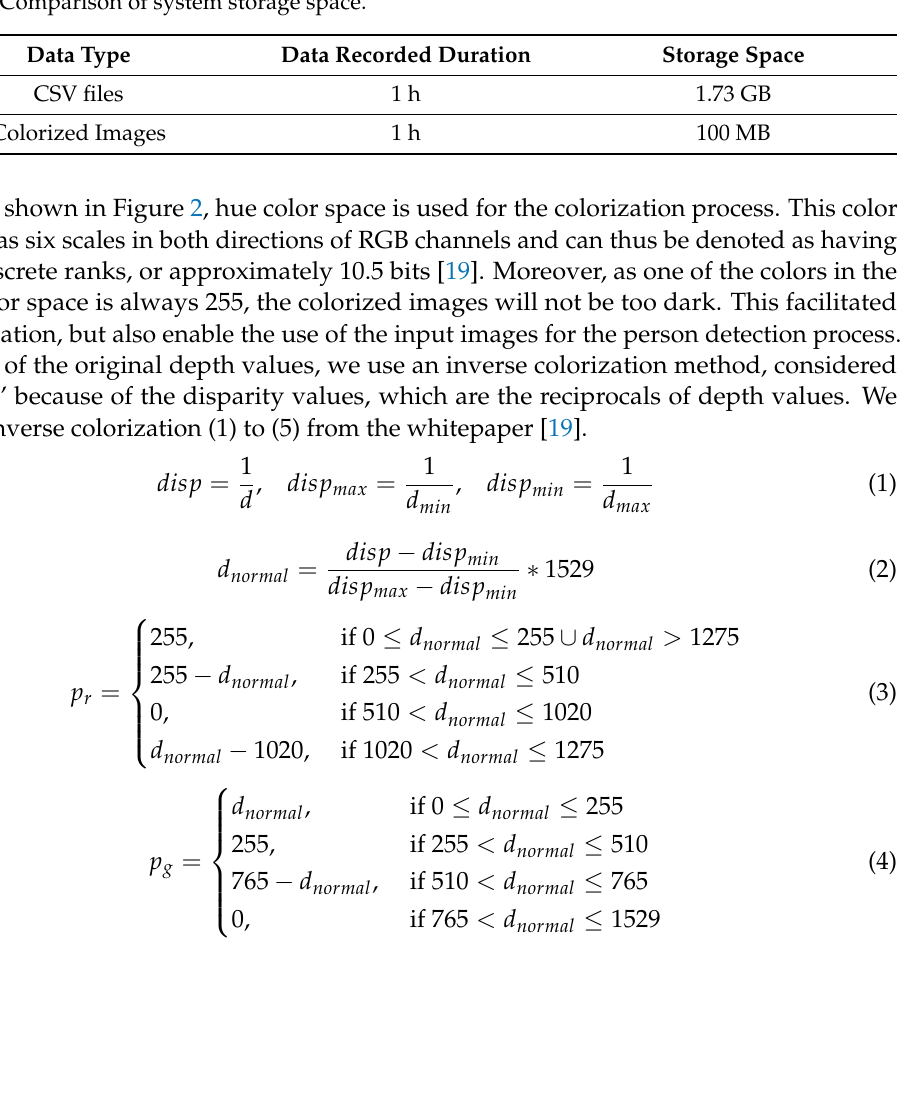
Table 1. Comparison of system storage